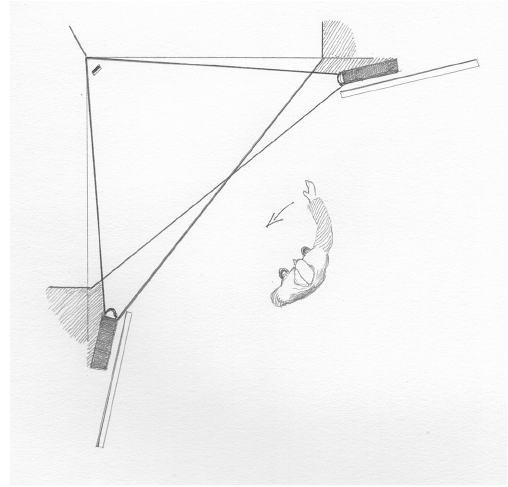
Figure 5. A sketch of the Viskbook installation seem from above. (Drawing: B.Laursen)